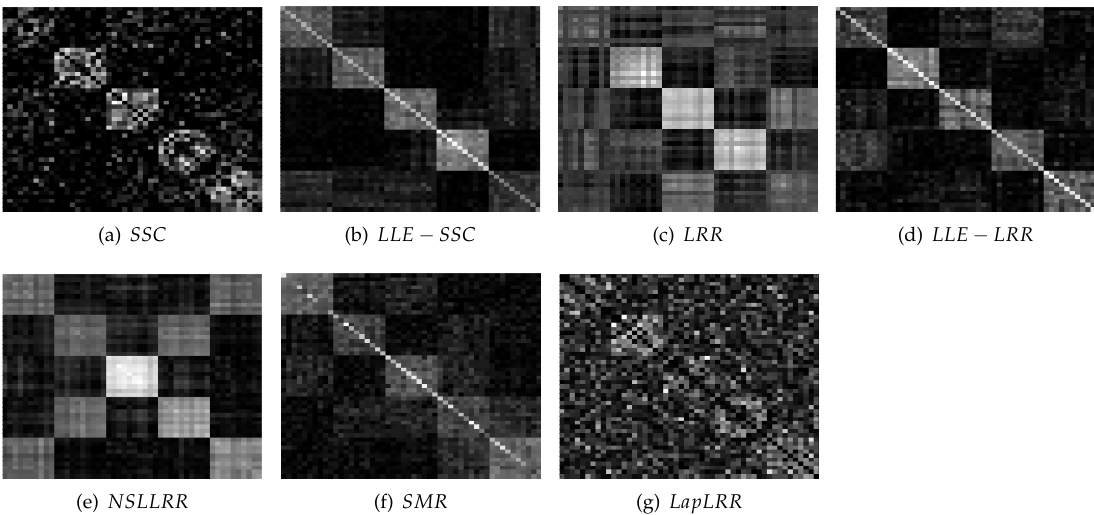
Figure 1. The affinity matrices of the clustering methods of ( a ) SSC; ( b ) LLE-SSC; ( c ) LRR; ( d ) LLE-LRR; ( e ) NSLLRR; ( f ) SMR and ( g ) LapLRR on the synthetic dataset with 20% Gaussian noise.